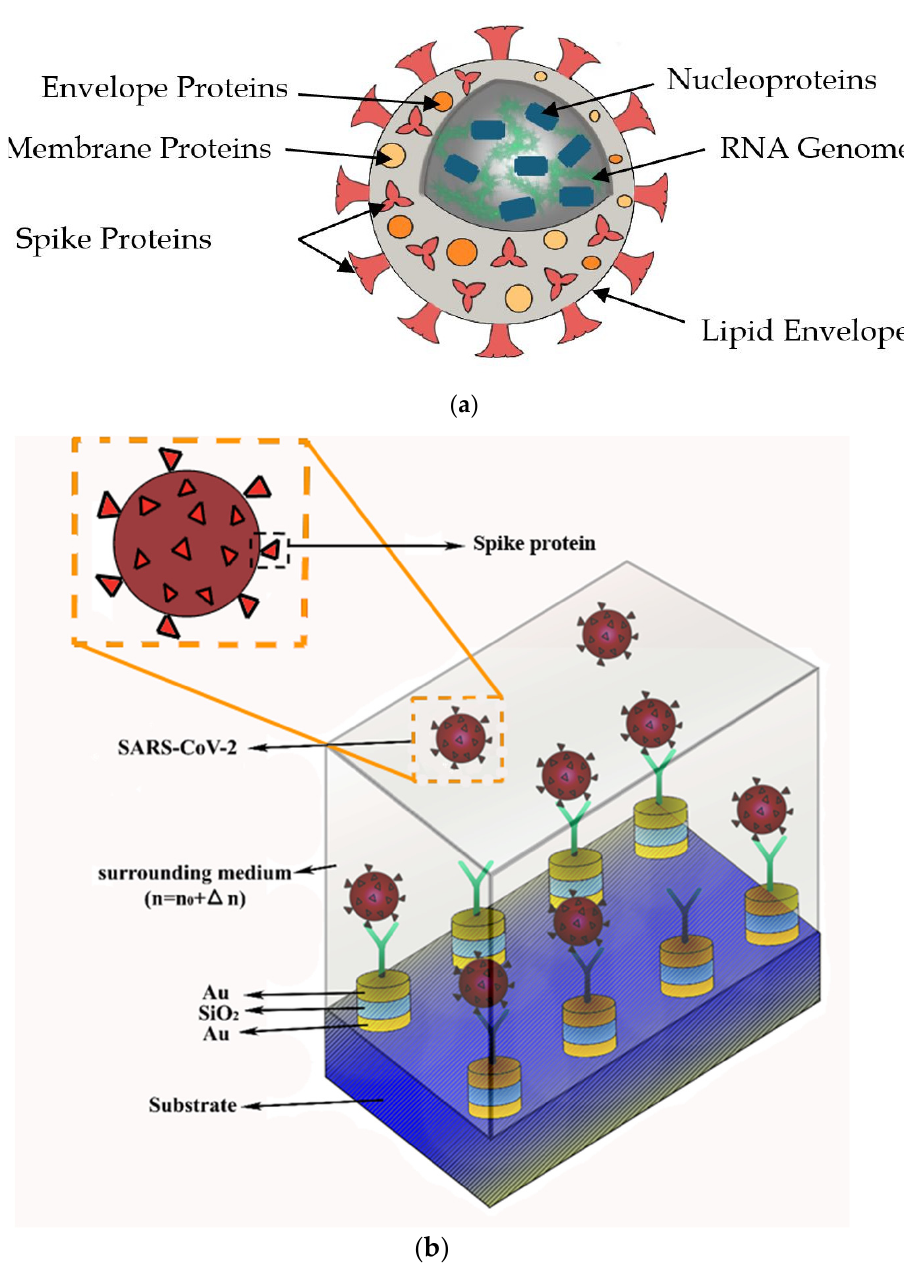
Figure 1. ( a ) SARS-CoV-2 structure; ( b ) structure of the proposed SARS-CoV-2 biosensor based on metal–insulator–metal